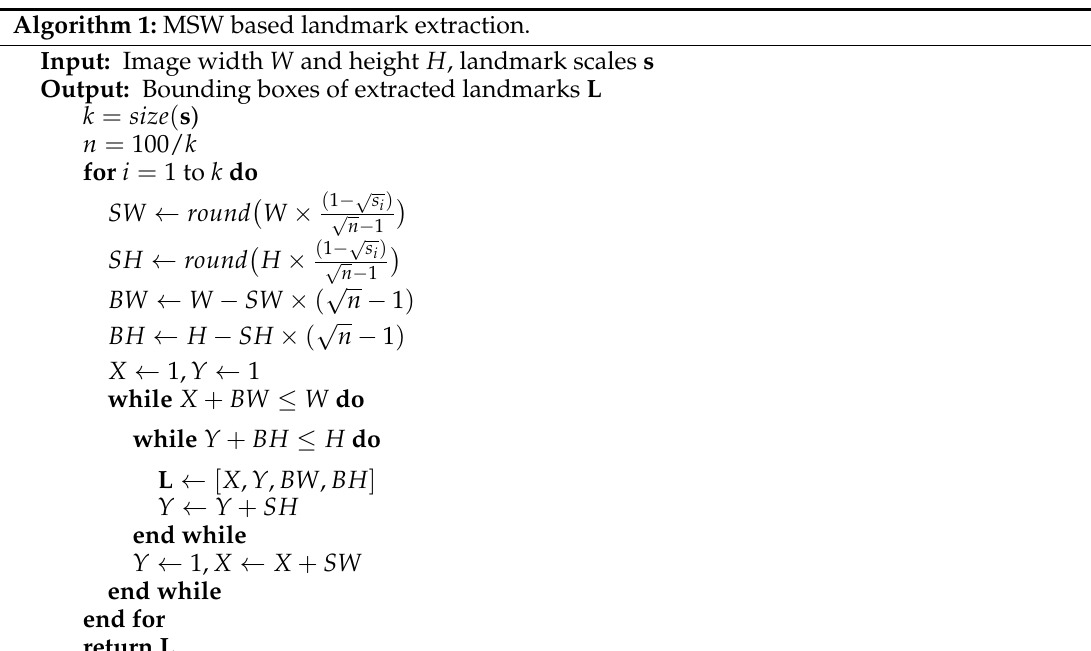
Algorithm 1: MSW based landmark